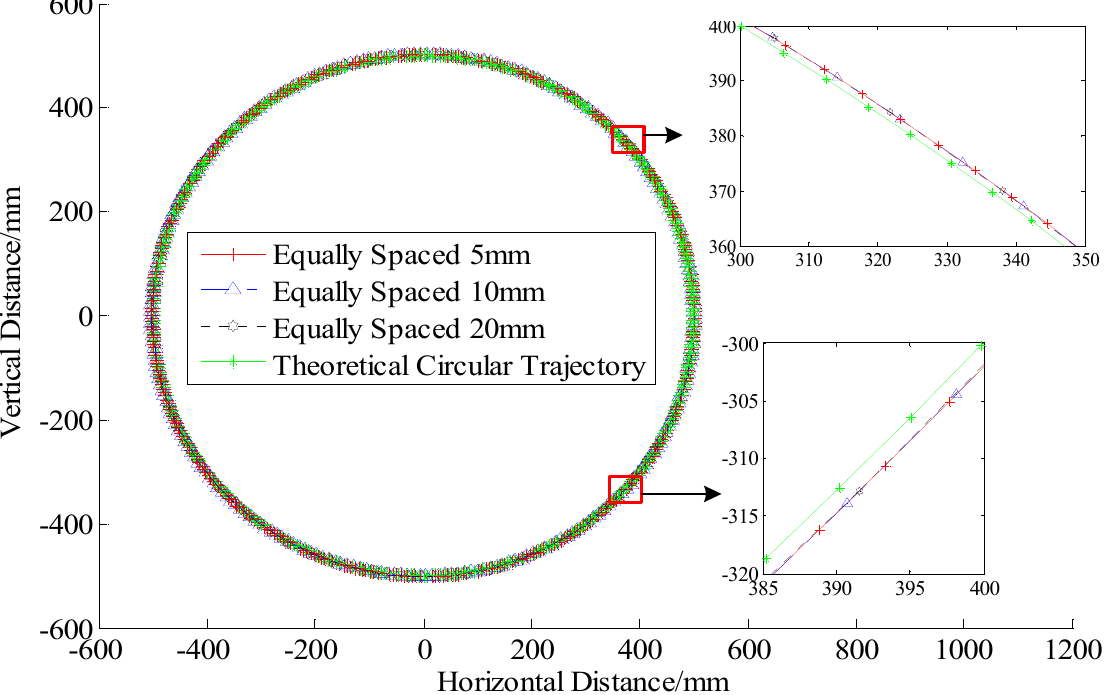
Figure 4. Projection position of sampling points with different measurement intervals—(D = 1 m).